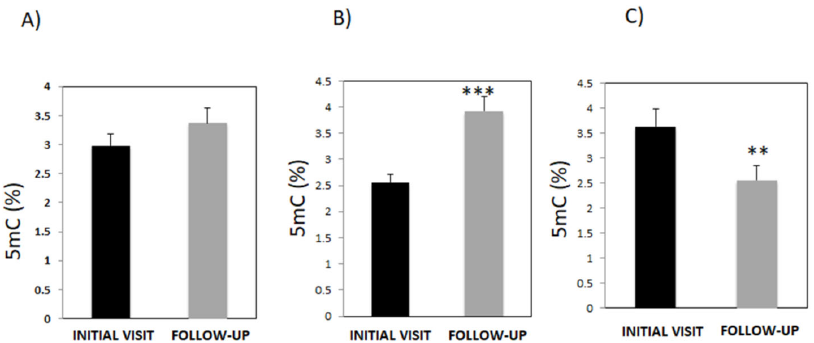
Figure 1. Analysis of global DNA methylation (5mC, %) in blood samples from patients with the diagnoses of neurological disorders and/or hypovitaminosis. ( A ) 5mC levels were measured in these patients ( n = 98) during the first visit and then during the clinical follow ‐ up. ( B ) Patients ( n = 51; Group A) whose 5mC levels were found to be higher during the follow ‐ up visit than during the initial consult. ( C ) Patients ( n = 47; Group B) whose 5mC levels decreased during the follow ‐ up visit versus the initial visit. Data are presented as the mean ± S.E.M; paired t test (** p < 0.01, *** p < 0.001). 5mC, 5 ‐ methylcytosine.